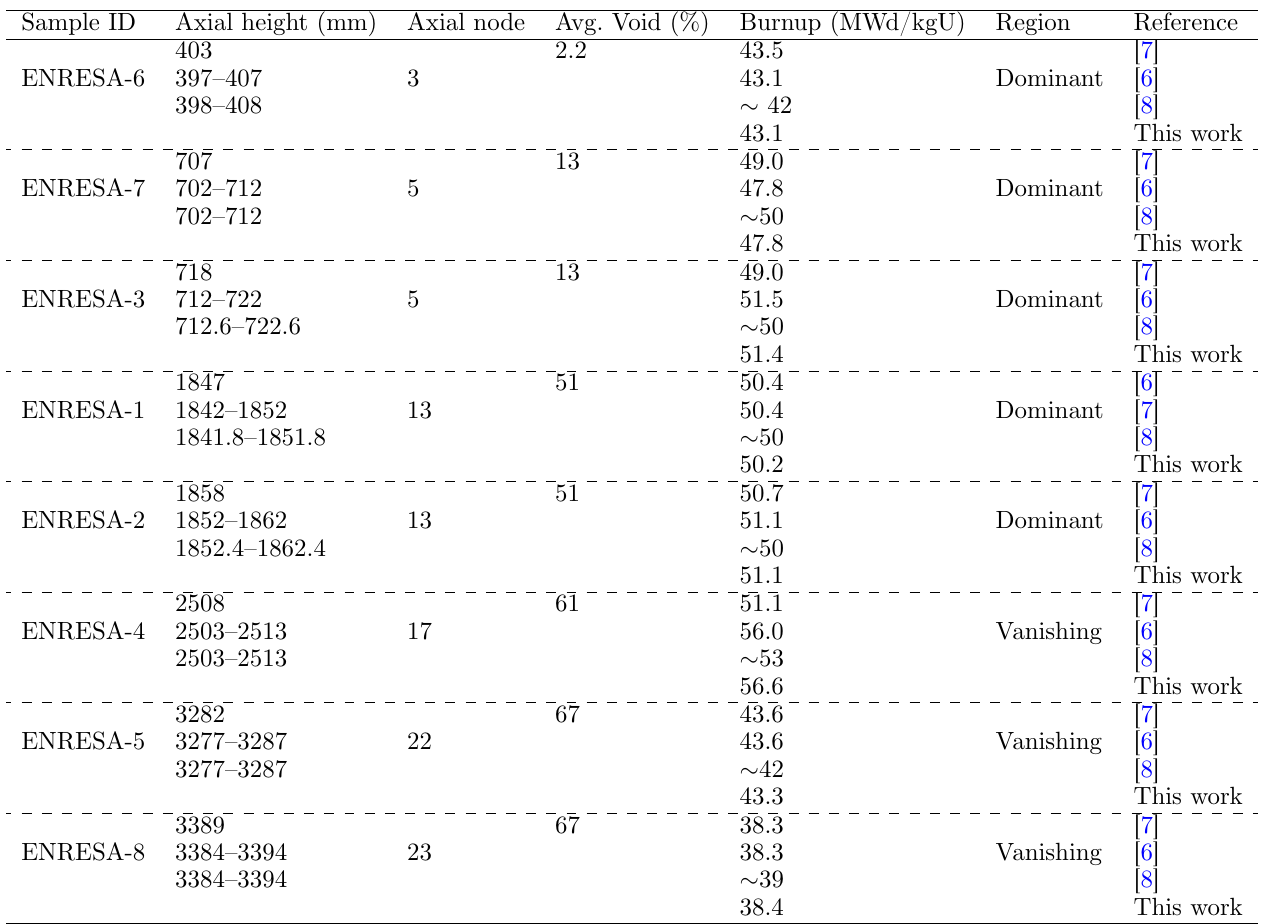
Table 2. Characteristics of the ENRESA samples, as found in the literature and this work (from the CASMO5-1 simulations). The axial height is measured from the bottom of the fuel rod end